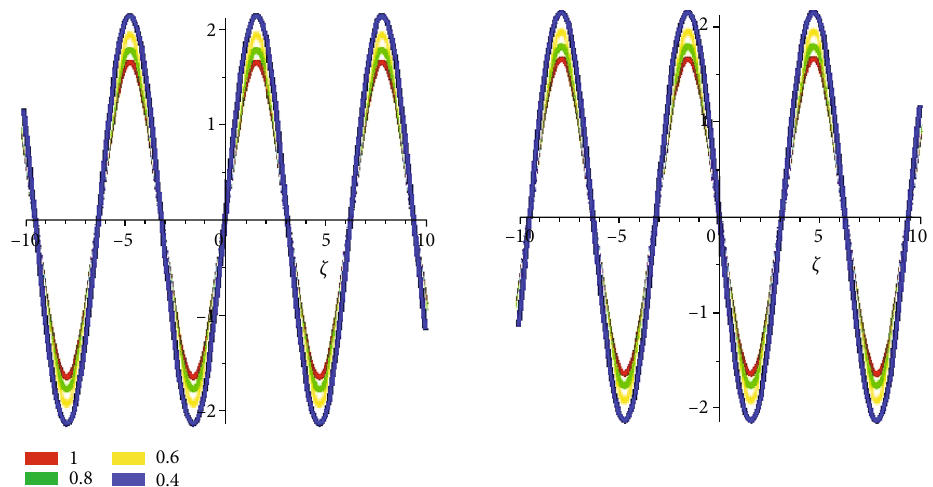
Figure 2: YDM solutions of μ ð ζ , Ψ Þ and ν ð ζ , Ψ Þ for example 1 at di ff erent value of δ .